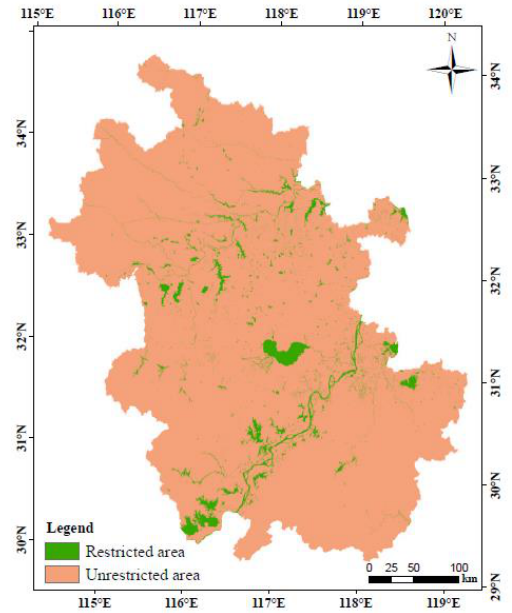
Figure 3. Restricted area for land use conversion. Green part is the water area that is restricted to be transformed, while land type conversion in the other part is allowed.